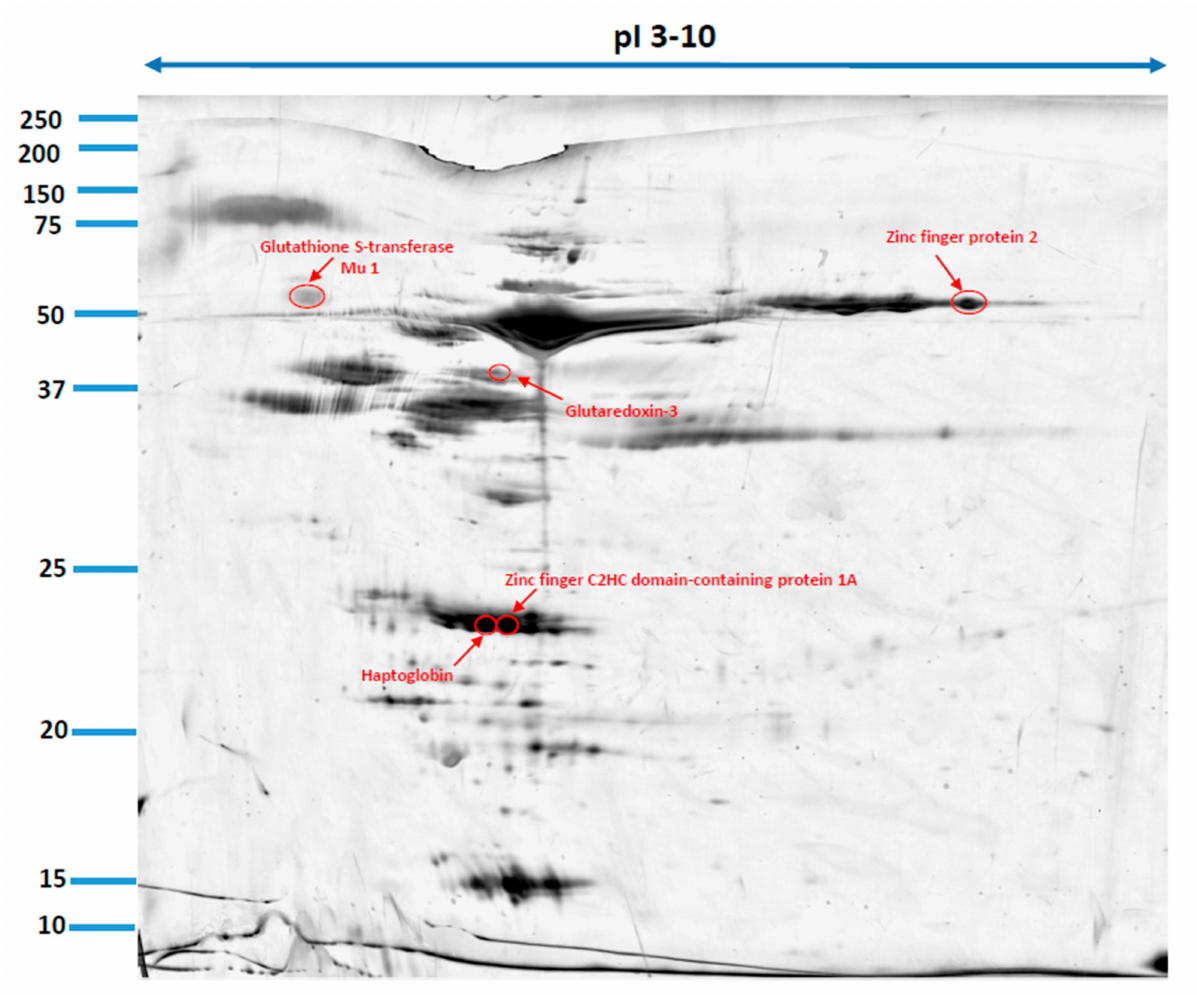
Figure 2. Fused image showing the condensed spot patterns from the experiment. Upregulated proteins are marked in